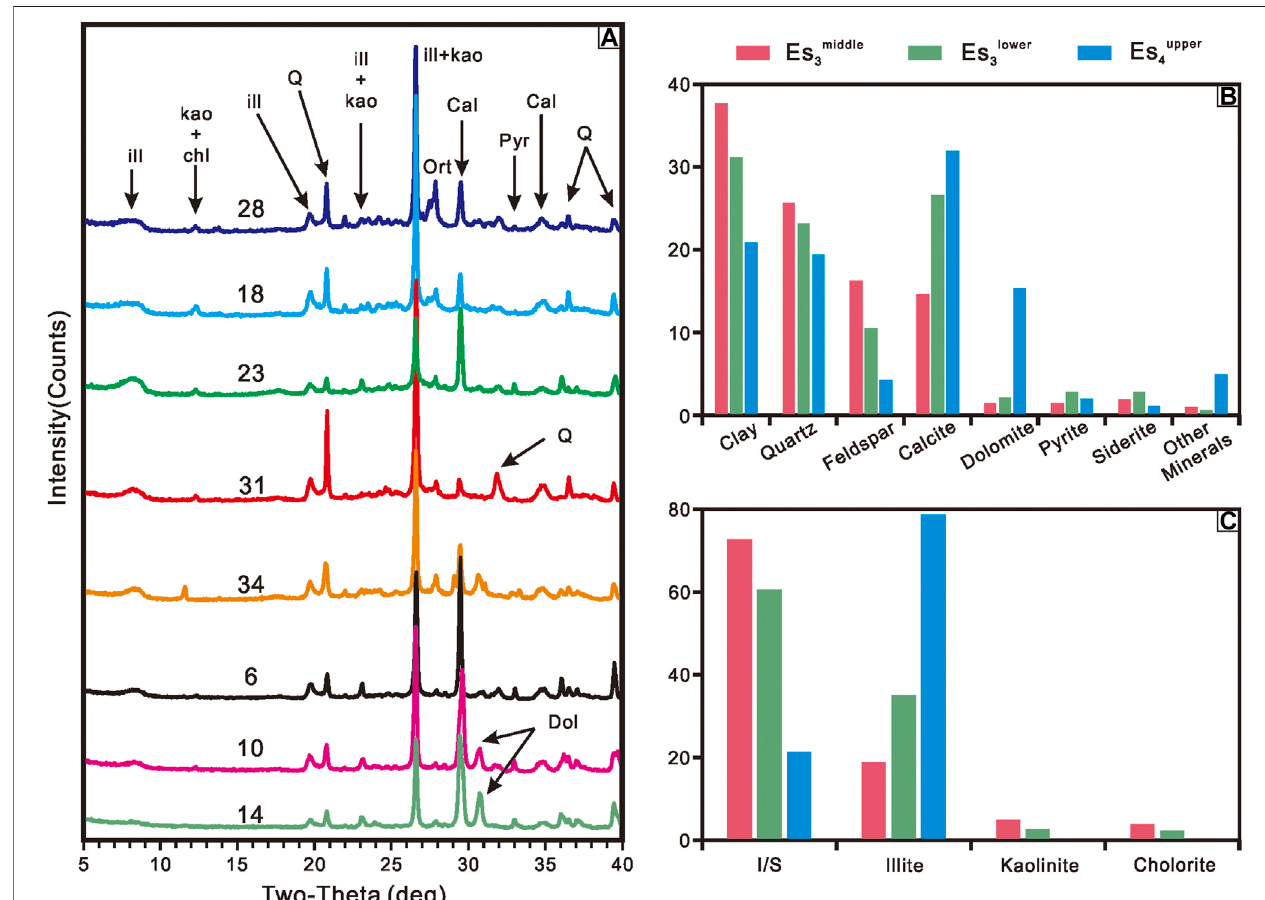
FIGURE2| Mineralcompositionsoftheshalesfrom differentsections. (A) XRDcurvesoftypicalsamplesfromEs 3middle (28, 18),Es 3lower (23,31), andEs 4upper (24, 6, 10, 14). The burial depths of the samples from each member increase from top to bottom. (B) Bulk mineral composition. (C) Clay mineral composition.